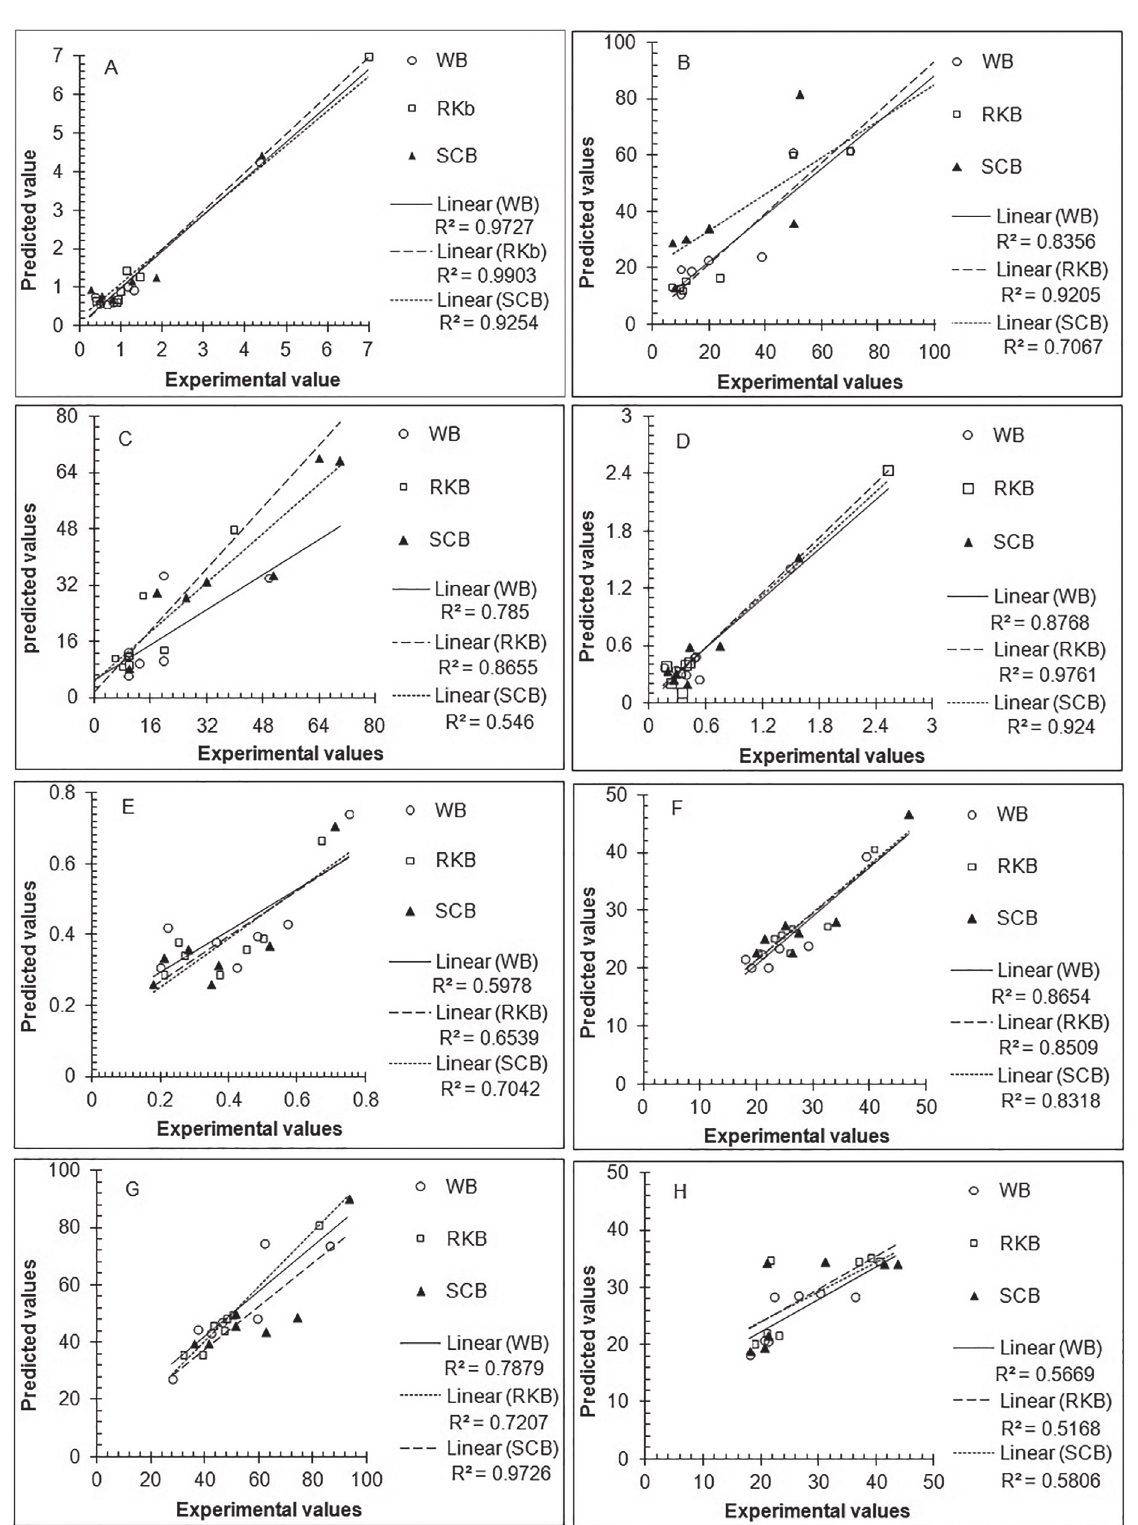
FIGURE 4 - Correlation between experimental and predicted values of phytochemical and antioxidant parameters of Bean seed extracts. A: total extractable components (TEC), B: total phenolic content (TPC), C: total flavonoid content (TFC) and D: Total antioxidant activity (TAOA), E: A: Iron reducing capacity (IRC), F: Linoleic acid reduction capacity (LARC), G: Hydroxyl radical scavenging capacity (HRSC), H: DPPH radical scavenging capacity (DPPH RSC), WB: white beans, RKB, red kidney beans, SCB: small common